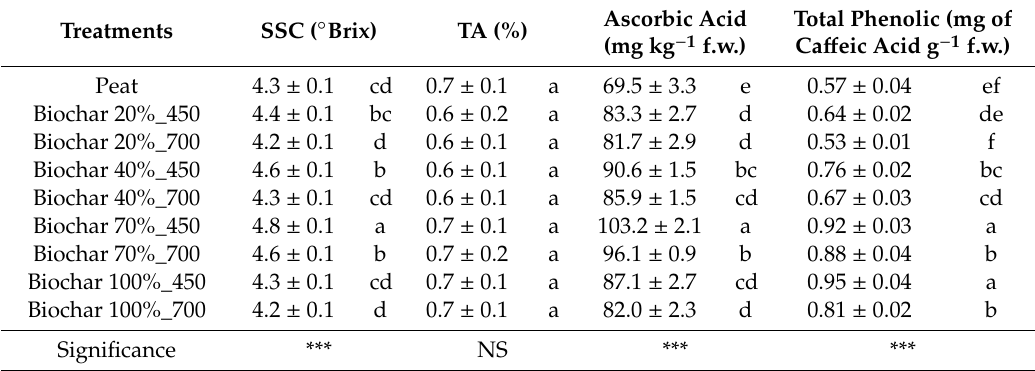
Table 4. Analysis of variance and means comparisons for SSC, TA, ascorbic acid and total phenolic of curly endive cultivated on di ff erent growing substrates in a protected environment.